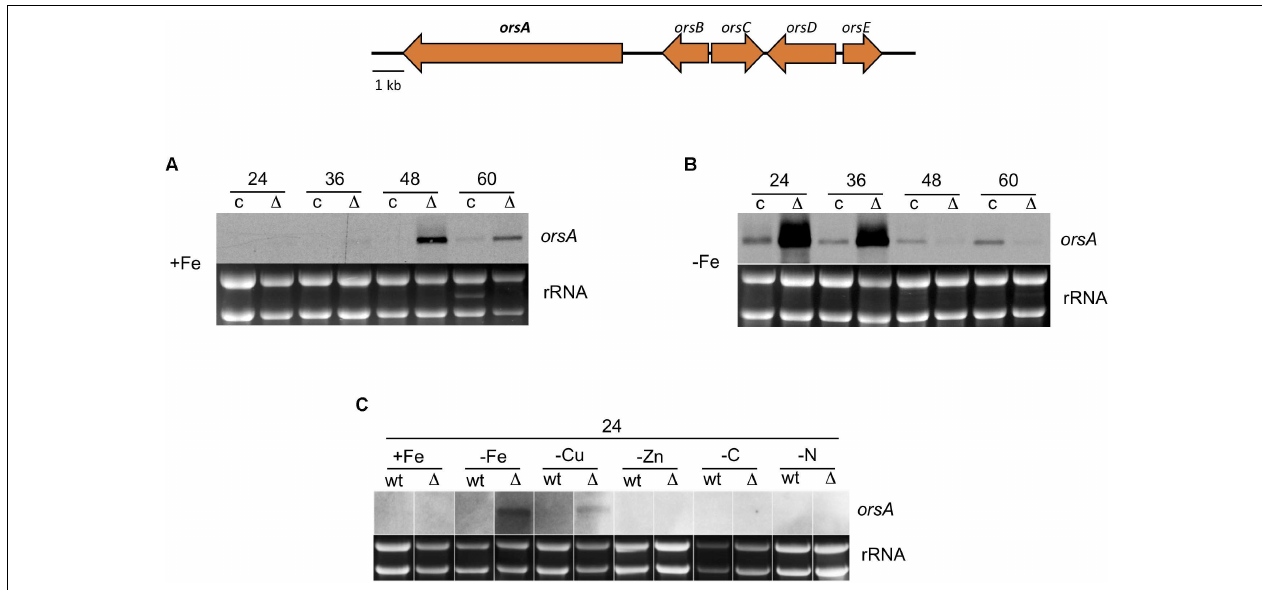
FIGURE 2 | Expression of orsellinic acid biosynthetic cluster genes in hosA knock out strains and wildtype after different times of growth and under different starvation conditions. A schematic representation of the five cluster genes ( orsA - E ) is shown on the top of the figure, an orsA probe (bold) was used for Northern analysis. For orsA expression analysis, (cid:49) hosA mutants and complemented strains were grown for 24, 36, 48 and 60 h at 37 ◦ C in a submerged culture (GMM) without (A) or with (B) iron starvation. Thirty micrograms of total RNA were botted, ethidium-stained rRNA was used as quality and loading control. orsA expression was also analyzed with 10 µ g of RNA of hosA mutants and wt grown for 24 h under iron ( − Fe), copper ( − Cu), or zinc ( − ZN) starvation and under carbon- ( − C, 0.1% glucose) or nitrogen- ( − N, 2 mM Gln) limitation (C)